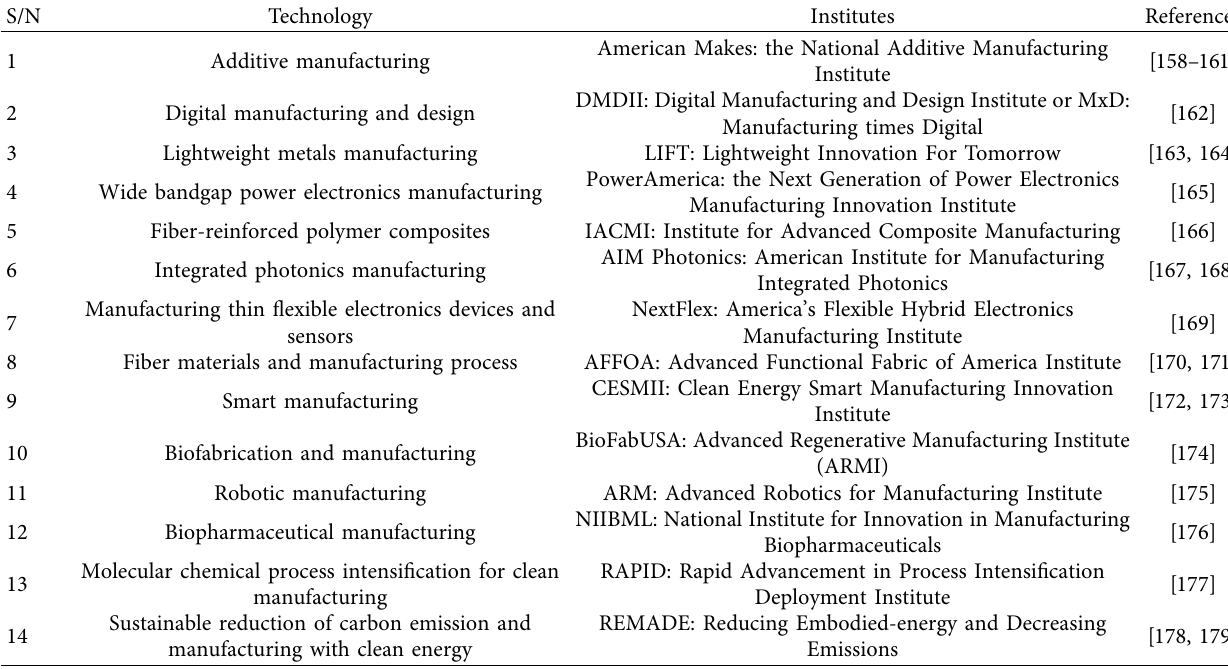
Table 8: Manufacturing USA institutes and the technology